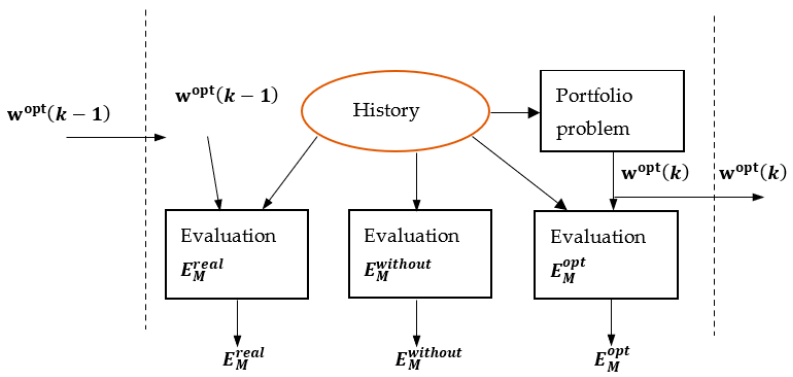
Figure 6. Rolling active business management by changing the recommendations for mean levels of disbursements. A flow chart of the operational rules of the algorithm is graphically interpreted in Figure 7. The initial data contain the monthly disbursements 𝑅 (cid:3036)((cid:3038)) and income 𝑅 (cid:3014)((cid:3038)) where k = 1 , n is the period of available data , i = 1 ,N are the type of of disbursement. These sets of data are normalized to 𝑟 (cid:3036)((cid:3038)) and 𝑟 (cid:3014)((cid:3038)) by means of operating with fewer values of the data. For the active management, the historical period is chosen to be t = 1 year, and